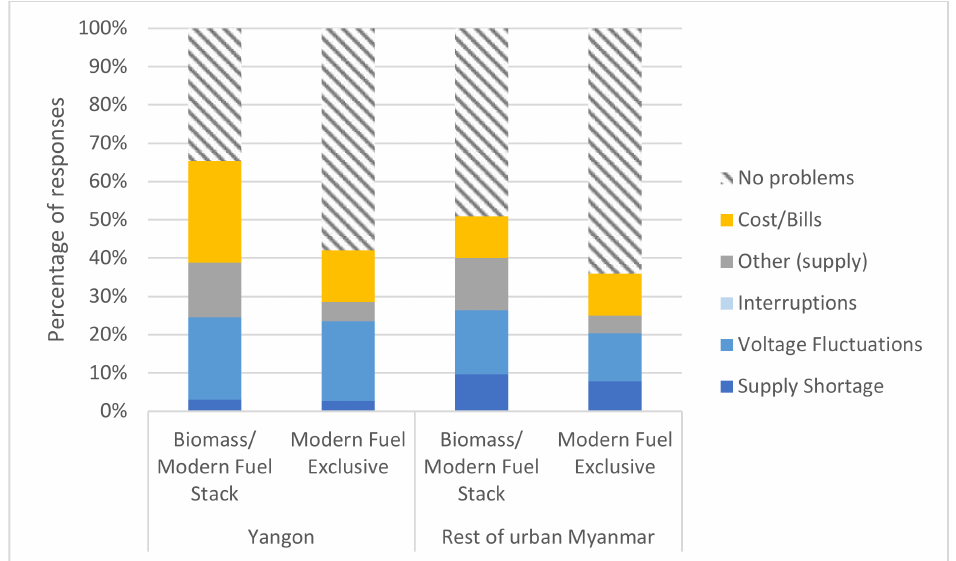
Figure 4. The main problems with a household’s electricity supply, Myanmar (up to two responses per